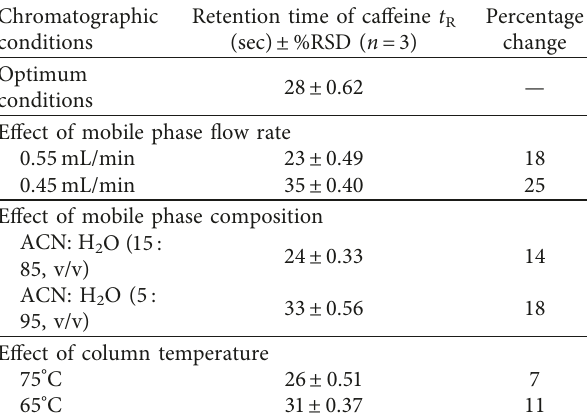
Table 4: Ruggedness study of the proposed